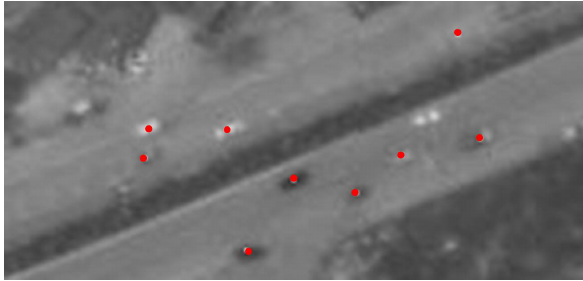
Figure 13: Result of vehicle detection. Vehicle detection result is marked by red point.